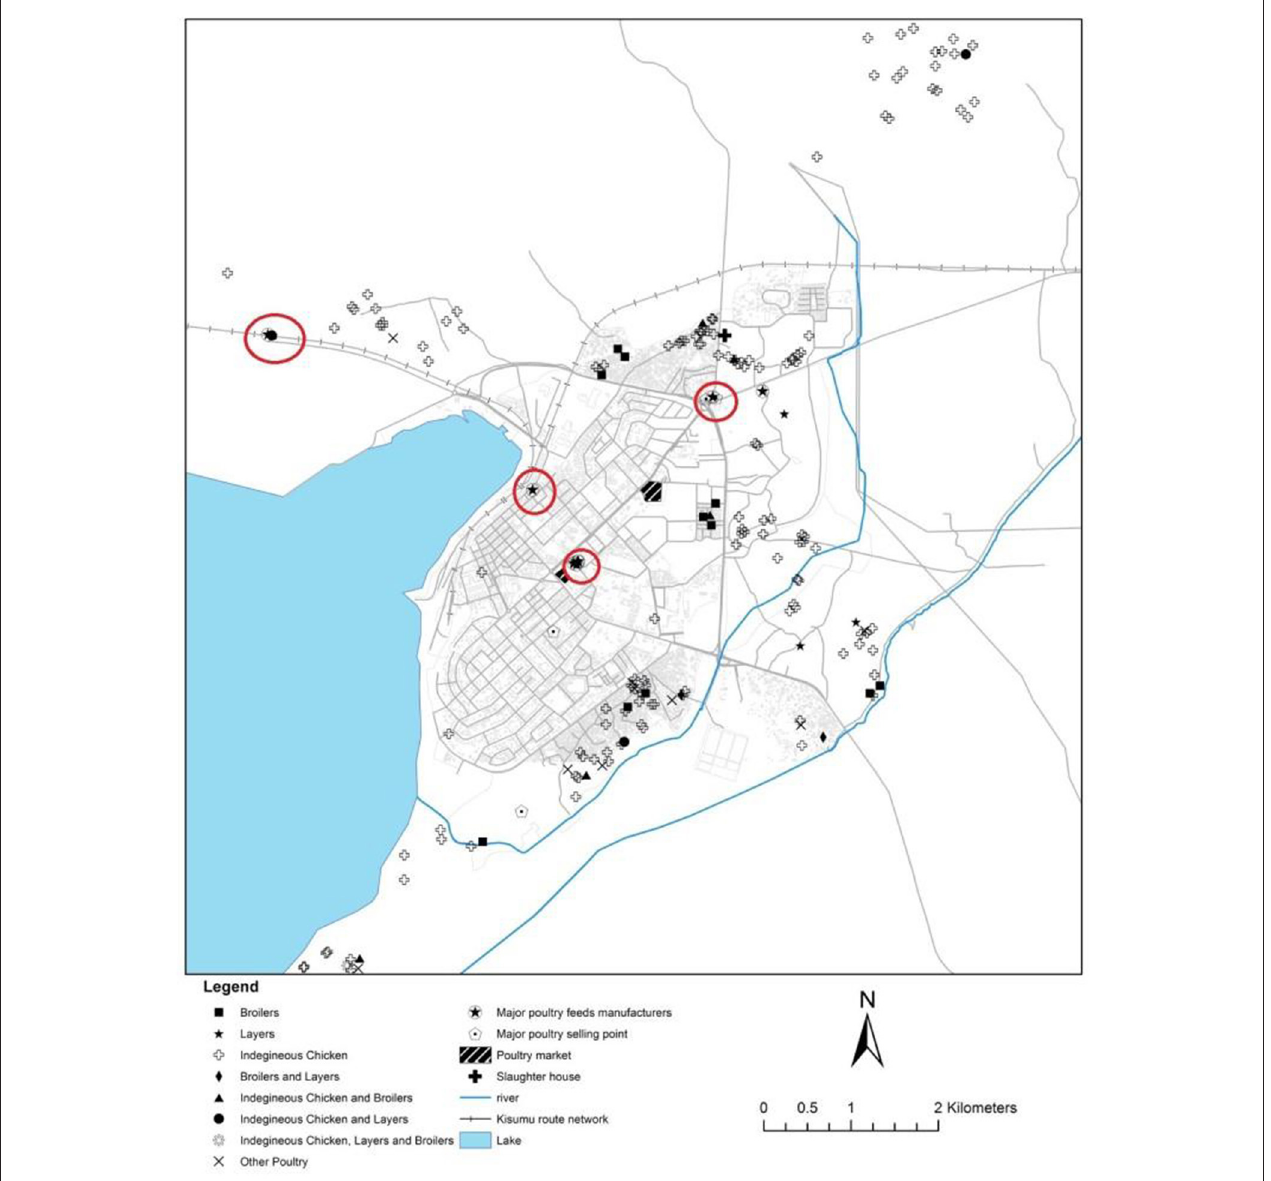
FIGURE 3 | Map of Kisumu showing location of poultry producers and input and output markets,